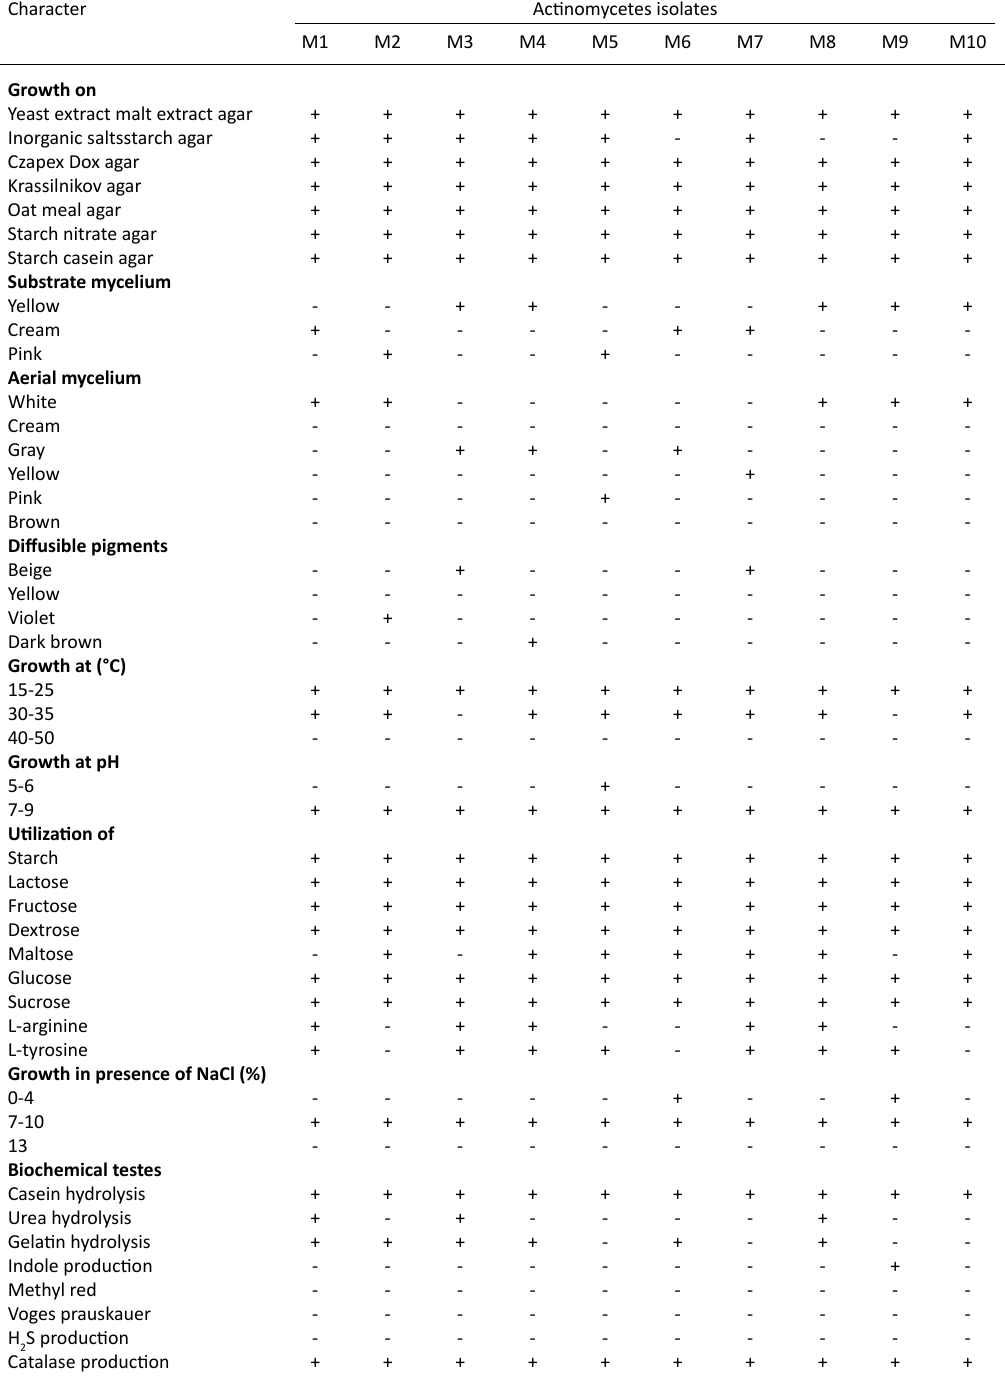
Table 3. Phenotypic characteristics of actinomycetes isolates Character